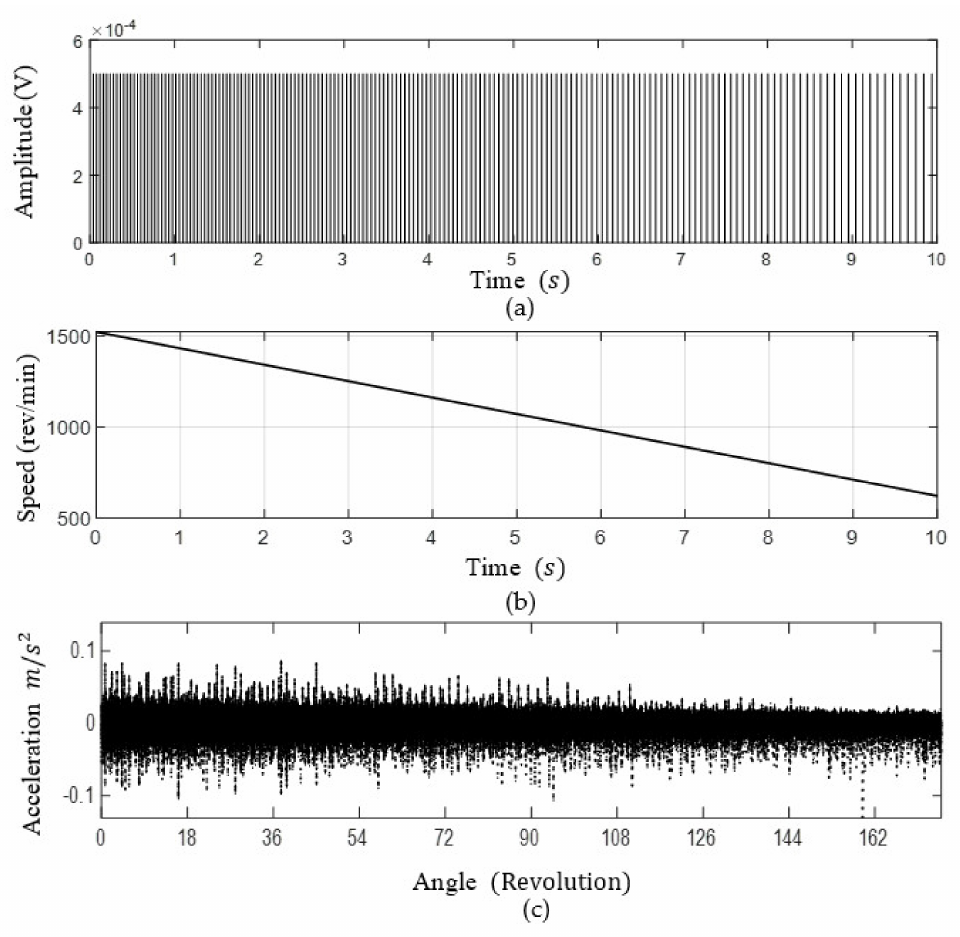
Figure 6. Resampling of the bearing vibration signal; ( a ) Tacho pulses; ( b ) Speed profile; ( c ) Resam- pled